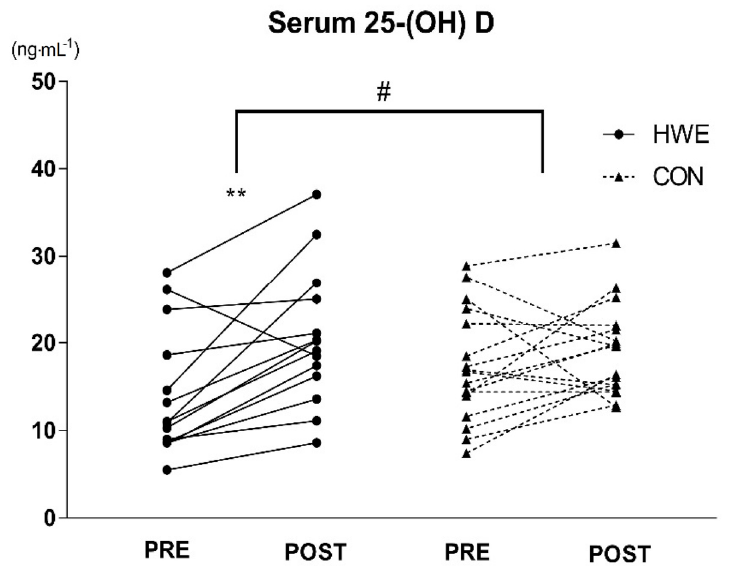
Figure 1. Serum 25-(OH) D before and after the four-month exercise program. For serum 25-(OH) D, statistical analyses revealed an increase between pre- and post-tests in the HWE group. HWE: high- impact weight-bearing exercise, CON: control. Significant difference between pre- and post-tests, ** p < 0.01. Significant interaction effect, # p < 0.05.